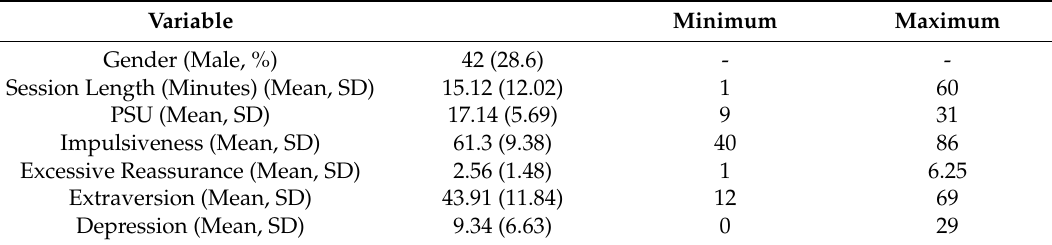
Table 1. Summary of descriptive statistics.